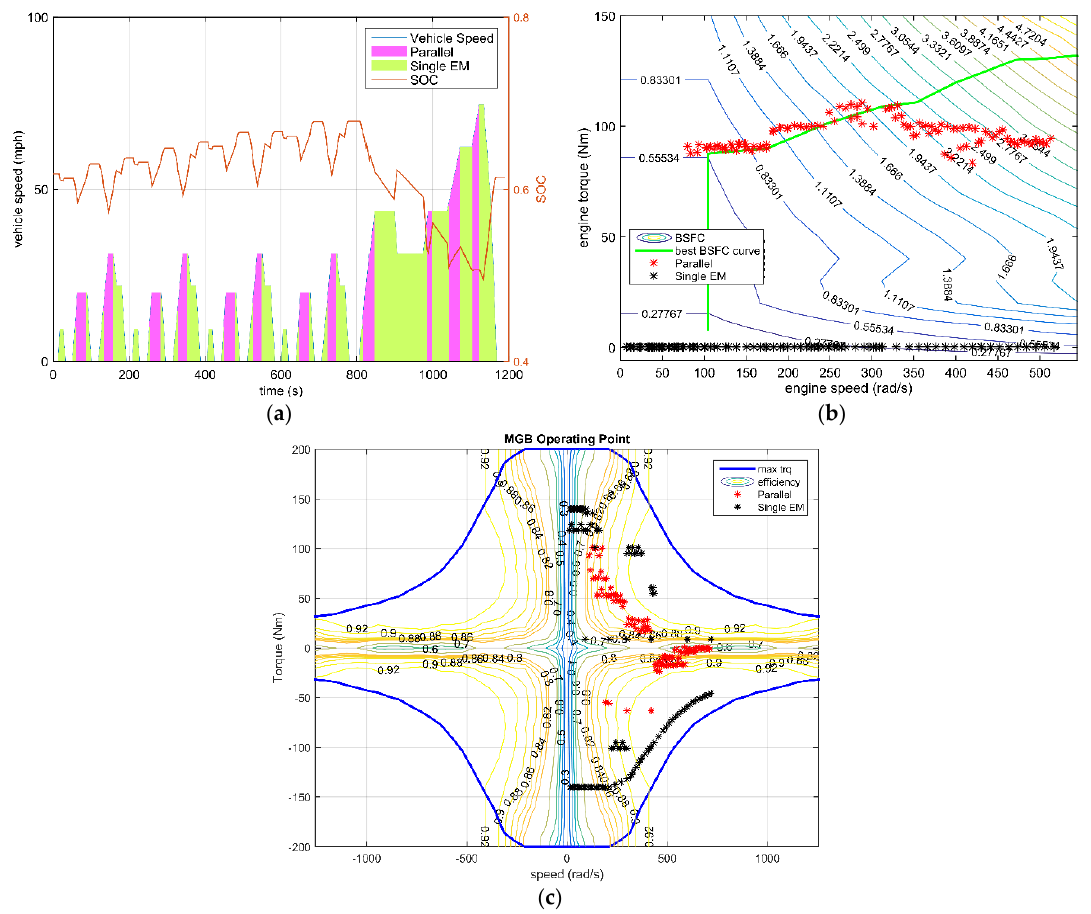
Figure 15. ( a ) Battery SoC trajectory and mode selection over the NEDC drive cycle; ( b ) engine optimal operation points over the NEDC drive cycle; and ( c ) EMB operating points over te NEDC drive cycle.